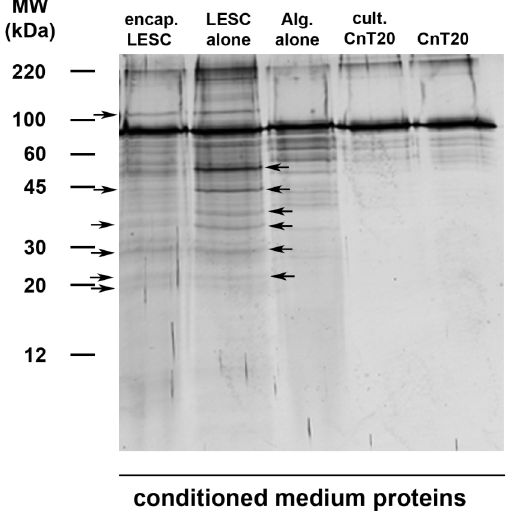
Figure 4. Profiles of secreted proteins from alginate-encapsu- lated and cultured LESC are distinct. Conditioned medium from alginate-encapsulated LESC (CM ALG-LESC ), LESC cultured in CnT20 (CM LESC ), alginate gels alone (CM ALG ), cultured CnT20 (CM CULT ), and non-cultured CnT20 (CM NON-CULT ) were treated with Laemmli buffer containing the reducing agent b -mercaptoethanol. Treated protein mixtures were separated using 15% acrylamide gels and proteins were stained using silver nitrate. Gel represents 3 individual experiments from 3 different corneoscleral rims.